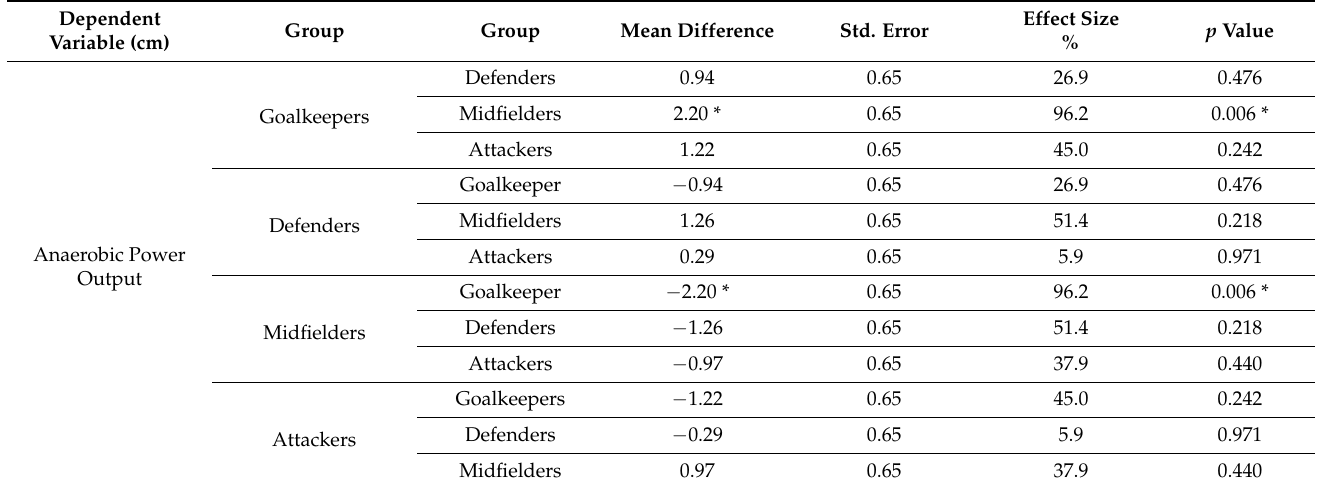
Table 3. Post-Hoc (Tukey) analysis of anaerobic output values of soccer players for their playing position.